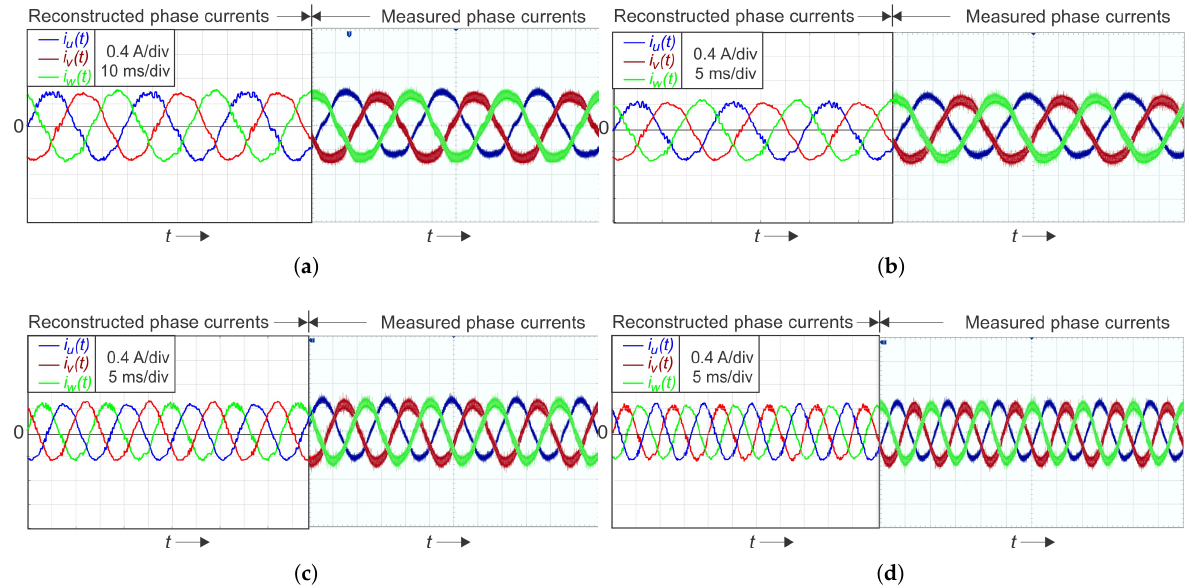
Figure 11. Single-shunt reconstruction of a three-phase current using SVM for low modulation index m i = 0.075 at a current magnitude of ˆ i u = ˆ i v = ˆ i w = 0.5 A: ( a ) reconstructed and oscilloscope- measured currents at f = 25 Hz; ( b ) at f = 50 Hz; ( c ) at f = 75 Hz; ( d ) at f = 100